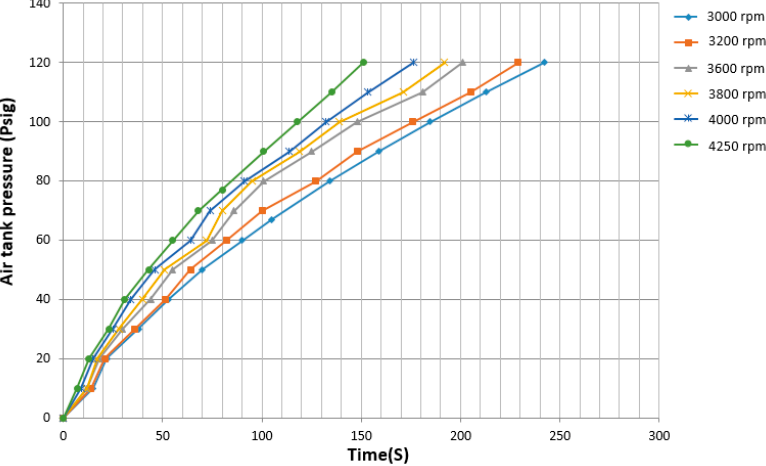
Figure 7. Pressure of the air storage tank at different internal combustion engine (ICE) speeds.